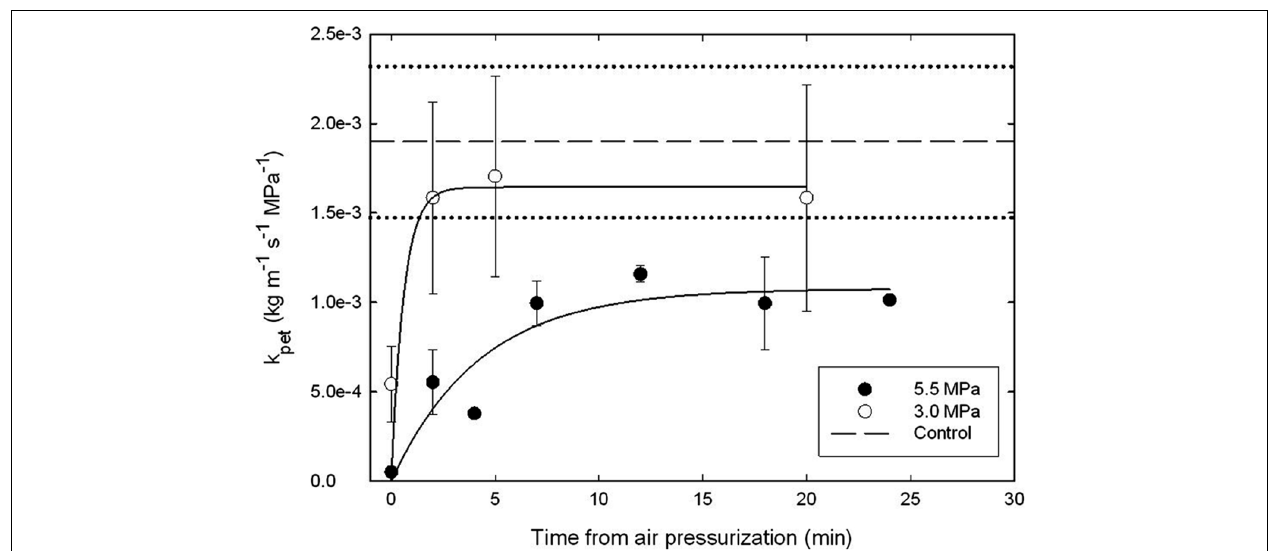
controls). Petioles remained attached to the trees until collected for k pet measurements. Note that k pet was restored to average control k pet values